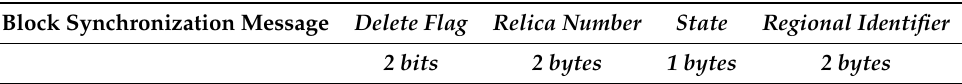
Table 2. Block Replica Delete Control Message Design. Block Synchronization Message Delete